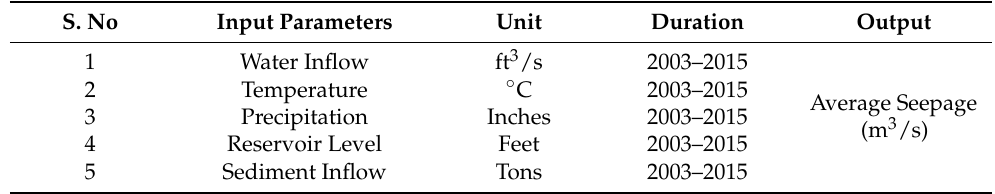
Figure 2. Research flow chart for Machine Learning Models.